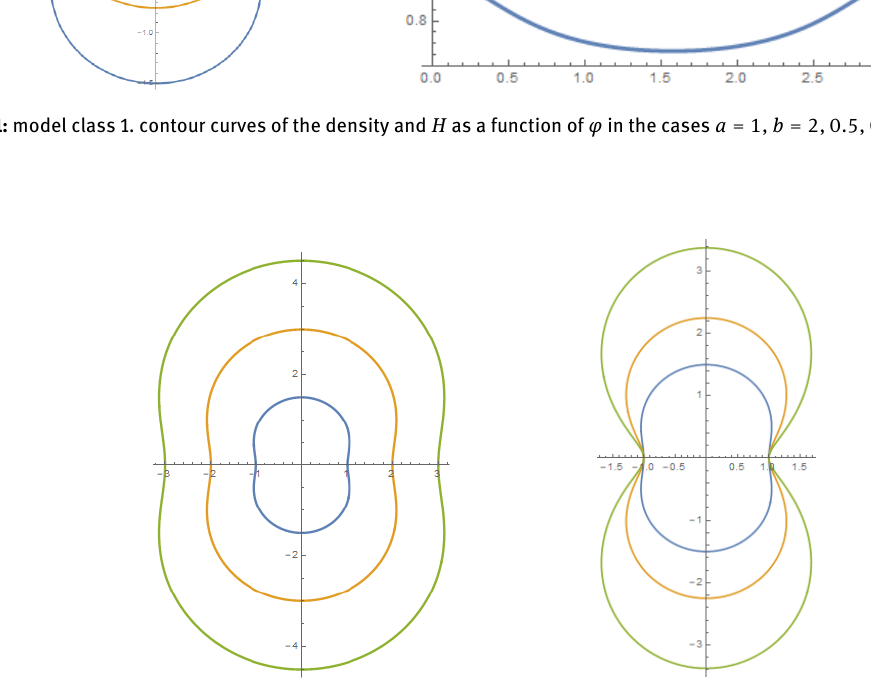
Figure 2: model class 1. left: several level sets of the density in the case a = 1, b = 2, c = 1, β = 0 . right: contour curves of the density in the cases a = 1, b = 2, c = 1, 2, 3, β =